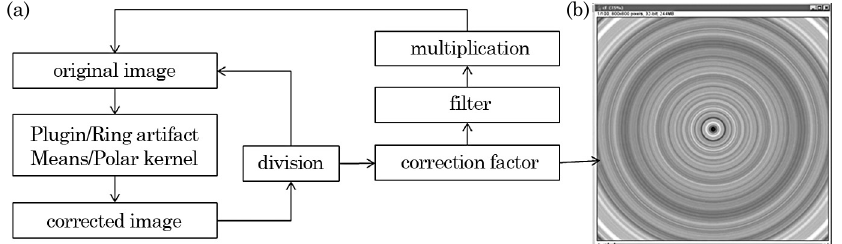
sample.figure 2. (a) flowchart of the image artifact extraction process. (b) image generated during the ring- shaped artifact extraction process. this is the correction factor that corresponds to the “noisy”